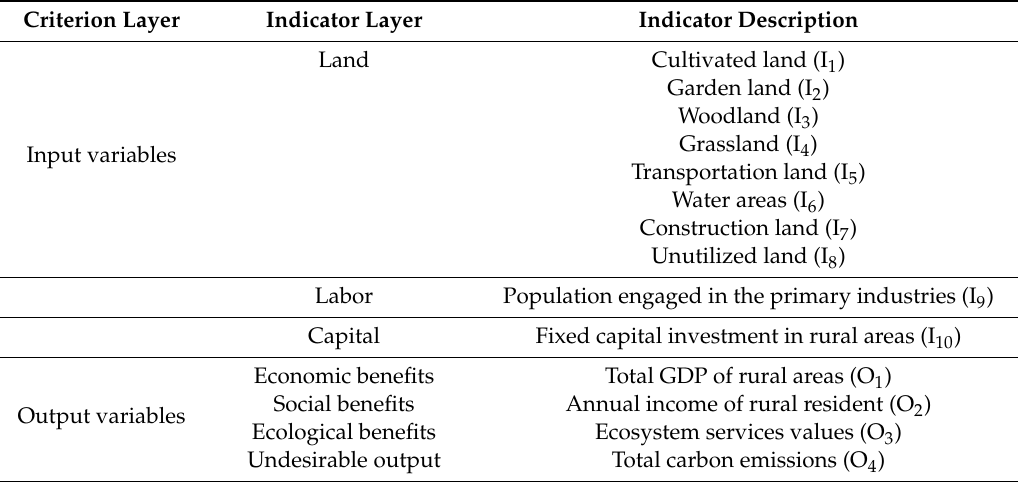
Table 1. Index system of rural land resource allocation e ffi ciency